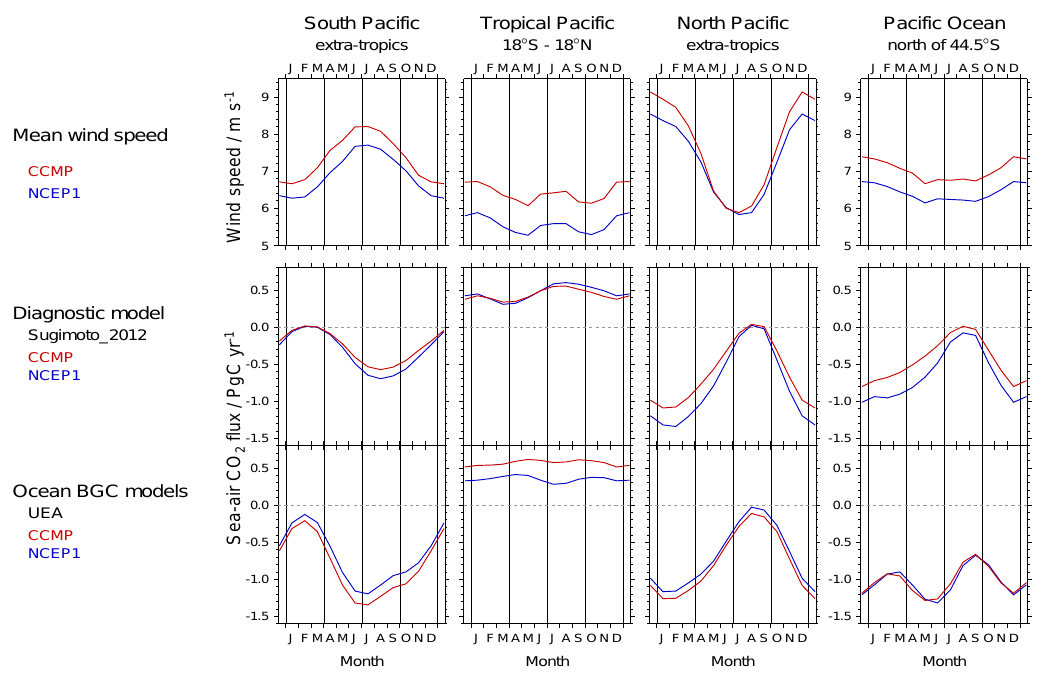
Fig. 11. Mean monthly wind speed of NCEP/NCAR Reanalysis 1 (NCEP1) (Kalnay et al., 2007) and Cross-Calibrated, Multi-Platform (CCMP) Ocean Surface Wind Product (http://podaac.jpl.nasa.gov/DATA_CATALOG/ccmpinfo.html) (Ardizzone et al., 2009; Atlas et al., 2011) (top), mean monthly air–sea CO 2 flux for 1990–2009 calculated with the diagnostic model of Sugimoto et al. (2012) (middle), and with the ocean biogeochemistry/general circulation model of Buitenhuis et al. (2010) (bottom) using the surface wind fields of NCEP1 and CCMP in the South Pacific extratropics (left), in the tropical Pacific (middle-left), in the North Pacific extratropics (middle-right), and in the entire Pacific region shown in Fig.